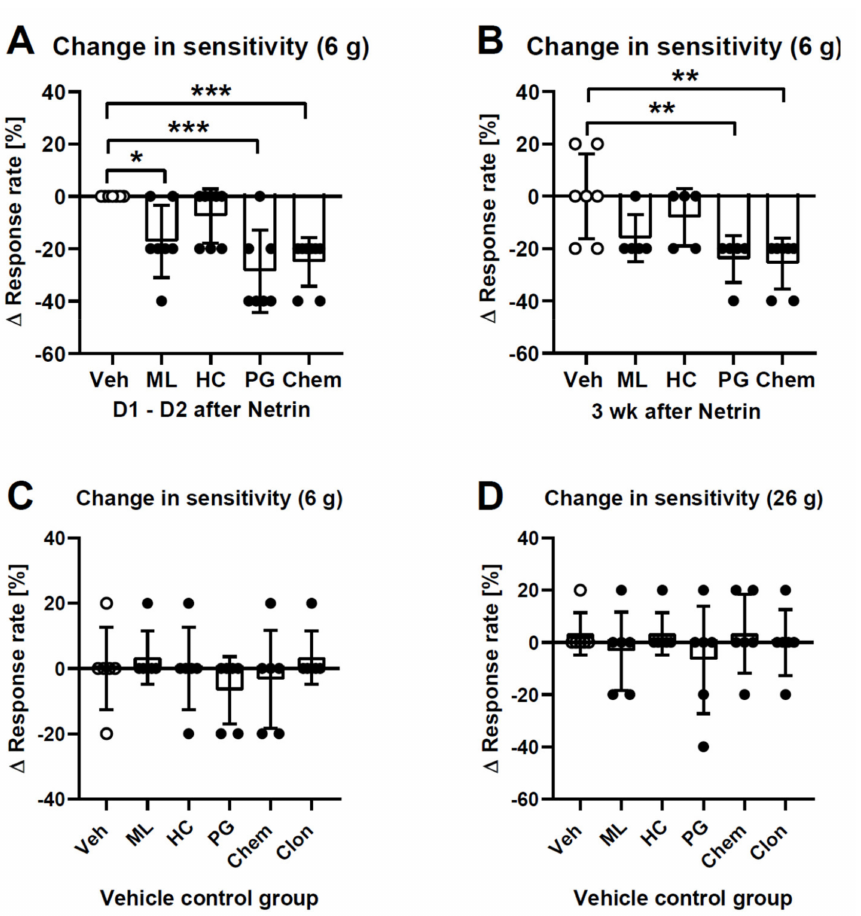
Figure 2. Attempts to reduce mechanical hypersensitivity induced by intrathecal administration of 2.0 µ g of netrin-1 with various compounds during the first two days ( A ) and during the third week ( B ) of hypersensitivity. Effect of the studied intrathecally-administered compounds on mechanical sensitivity in healthy control animals assessed at a low (6 g; ( C )) and high (26 g; ( D )) test stimulus intensity. Veh = vehicle, ML = ML-204 (10 µ g), HC = HC-070 (19 ng), PG = pregabalin (30 µ g), Chem = Chembridge-5861528 (10 µ g), Clon = clonidine (10 µ g). Each bar represents the mean change in the withdrawal response to repeated application of the test stimulus at the force of 6 g ( A – C ) or 26 g ( D ) 15 min following intrathecal administration of the studied compound; 0% represents the response rate before administration of the studied compound, and response rate changes < 0% represent an antihypersensitivity effect induced by the tested compound. In ( A ), n = 7, except n HC/Chem = 8. In ( B ), n Veh/Chem = 7 and in other groups n = 5. In ( C , D ), n = 6 in all groups. The error bars represent S.D. * p < 0.05, ** p < 0.01, *** p < 0.005 ( t -test with Bonferroni correction). The absolute response rates in the vehicle groups to stimulation at a force of 6 g were 40% ± 20% in ( A ), 31% ± 10% in ( B ), 13% ± 10% in ( C ), and to stimulation at a force of 26 g was 80% ± 13% in ( D